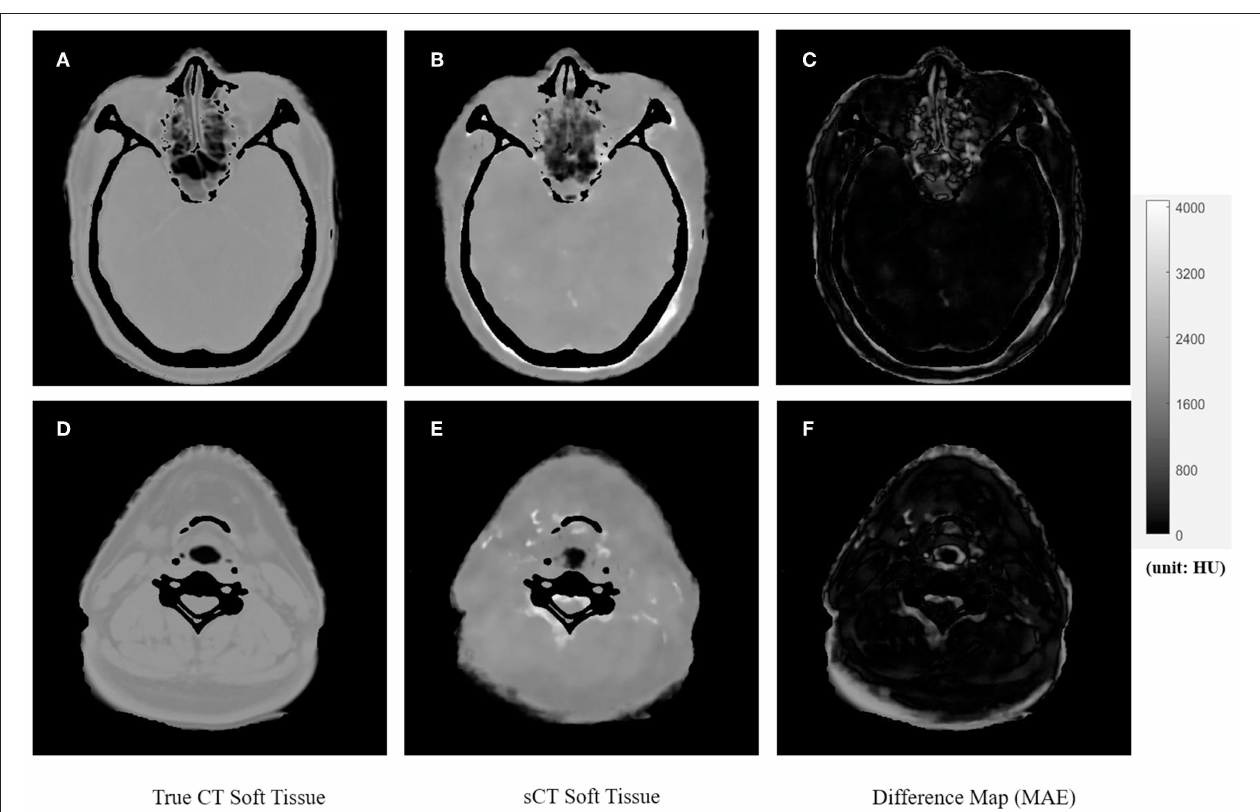
FIGURE 5 | The comparison of true CT and synthetic CT for soft tissues. The first column is true CT images. The second column is the synthetic CT images. The third column is the difference maps. (A–C) Showed soft tissue in the head and nasal region. (D–F) Showed soft tissues in the neck region. Gray bar indicated the mapping from CT number to gray scale in the difference